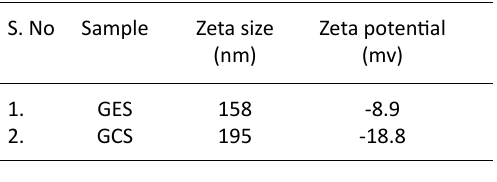
Table 2. Zeta size and Zeta potential of Psidium guajava silver nanoparticles with Ethanol and Chloroform extract S. No Sample Zeta size Zeta